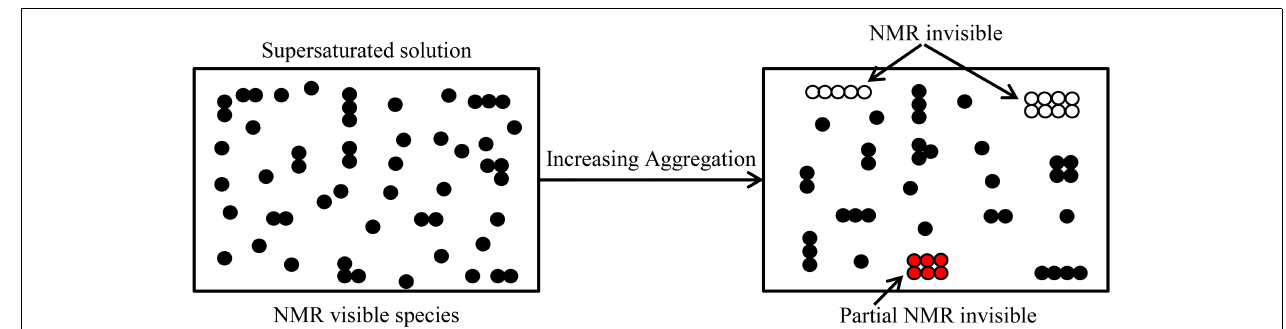
FIGURE 1 | Depiction of molecules in a supersaturated solution with increasing aggregation and their visibility in an NMR diffusion measurement. Dimers and higher oligomers (some have complex shapes)